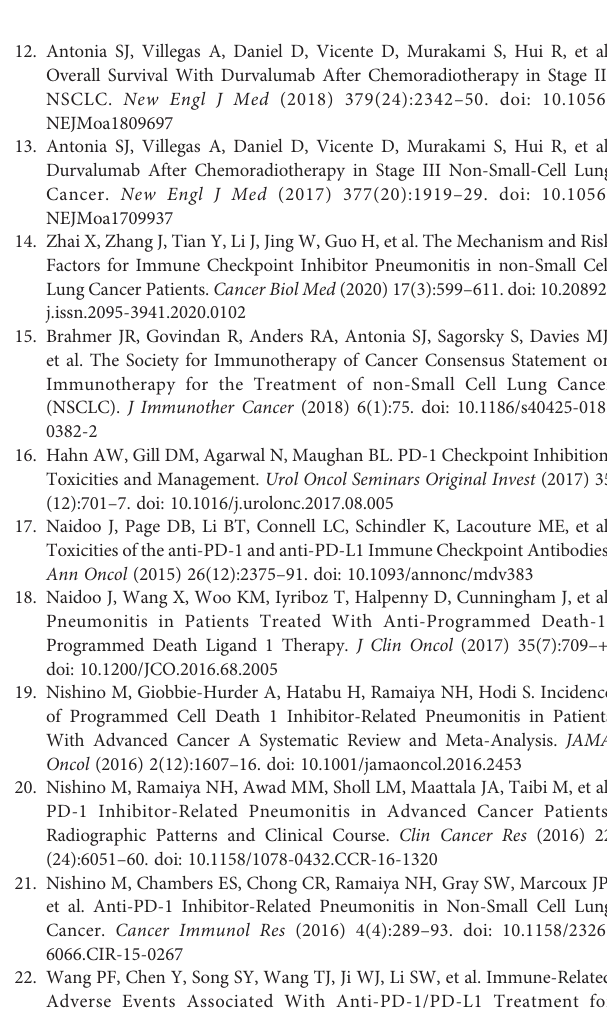
Supplementary Figure 1 | Relationship between initial corticosteroids dose and checkpoint inhibitor pneumonitis outcome. Kaplan-Meier curves by initial corticosteroids dose (mg/d) (A) , by initial corticosteroids dose (mg/kg/d) (B) . Supplementary Figure 2 | Relationship between initial corticosteroids dose and overall survival. Kaplan-Meier curves by initial corticosteroids dose (mg/d) (A) , by initial corticosteroids dose (mg/kg/d) (B)